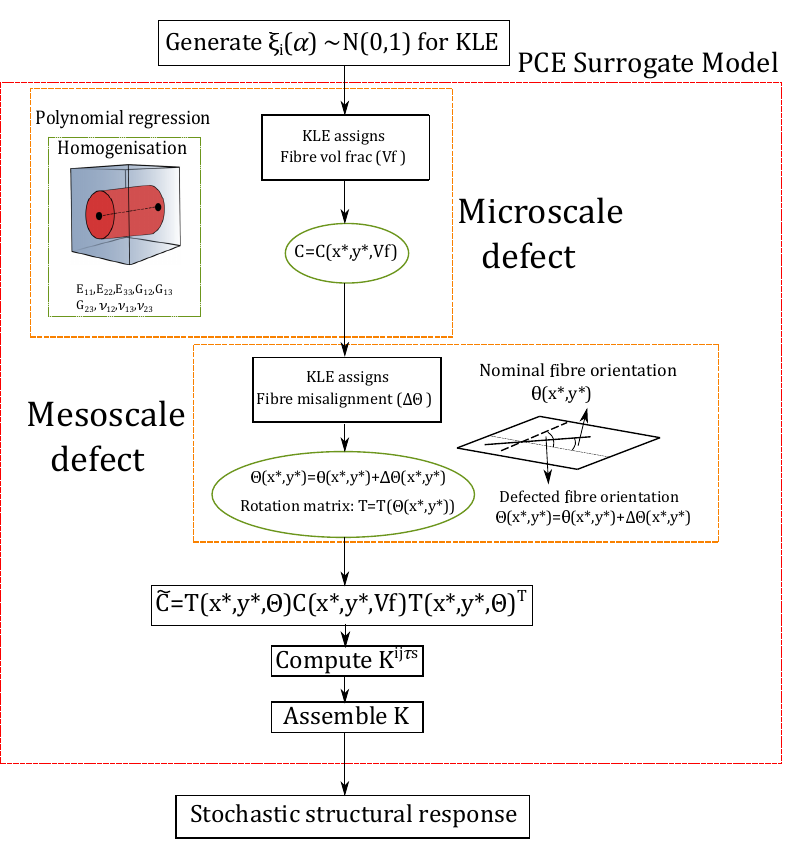
Figure 8. Flow-chart of the stochastic structural analysis